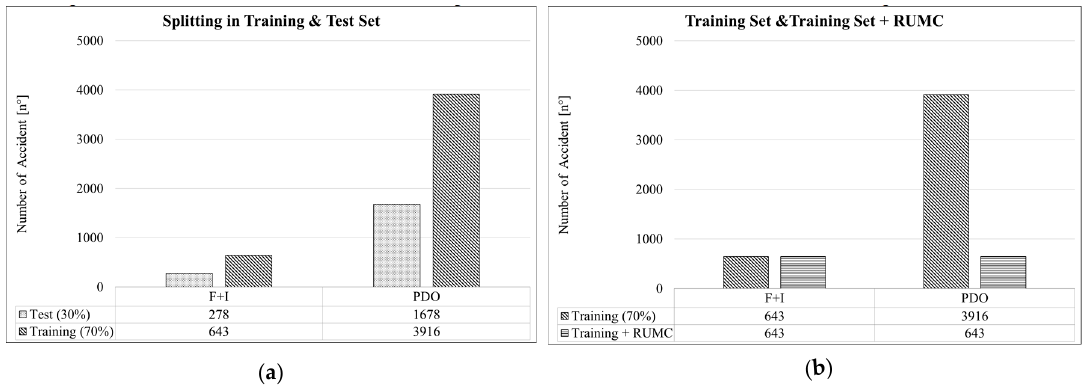
Figure 5. Training sets and test set: ( a ) random split into training set (70%) and test set (30%) and ( b ) imbalanced training set and RUMC-based training imbalanced training set and RUMC-based training set.